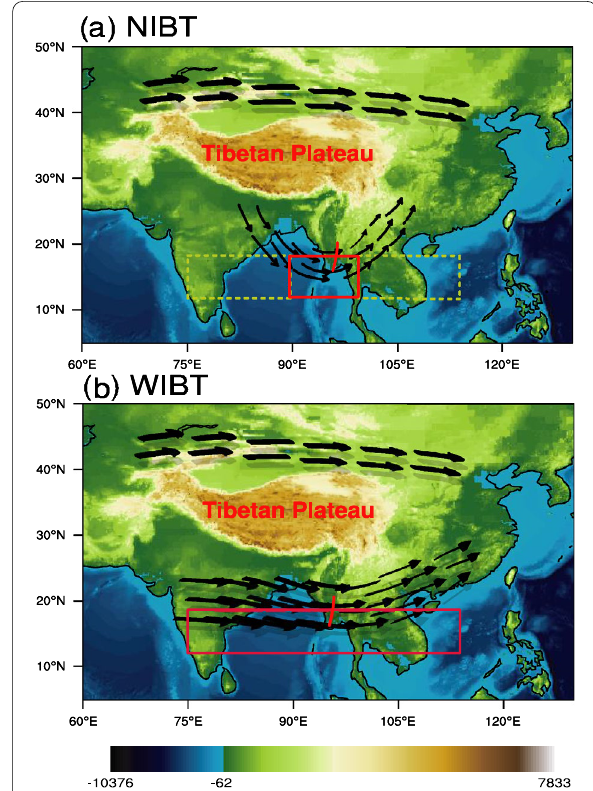
Fig. 1 Schematic diagram of the ( a ) NIBT‑ and ( b ) WIBT‑like circulations. The red solid boxes represent the regions which are used to define the NIBT and WIBT indices. The red curve indicates the IBT axis. The black vectors denote two branches of 700‑hPa winds along the north and south the Tibetan Plateau. Shadings denote the altitudes above/below sea level, as shown by the color bars at the